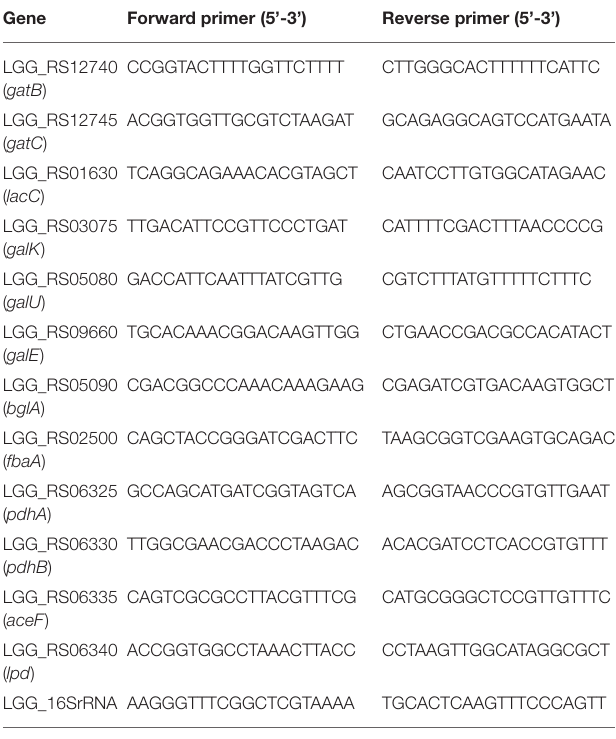
TABLE 1 | List of primers for